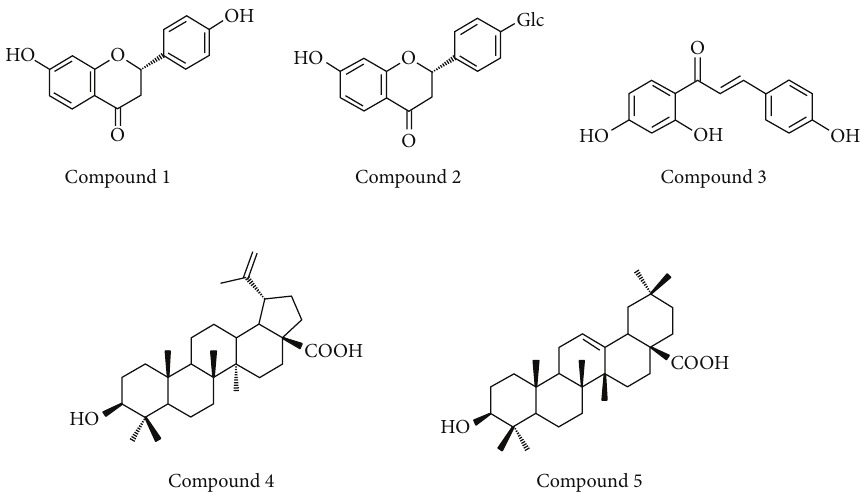
Figure 1: Structural formulas of compounds